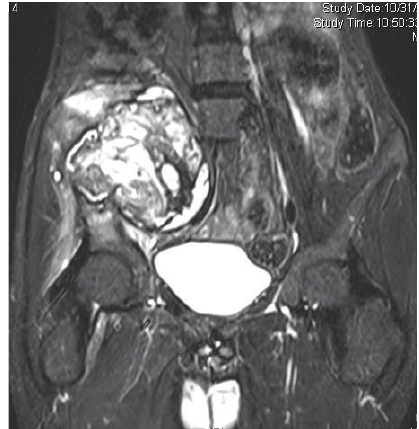
Figure 2: MRI T2W coronal view showing a large lytic lesion involving the right iliac bone with a large soft tissue component, with heterogeneous signal intensity with lobulated margins and hypointense capsule.